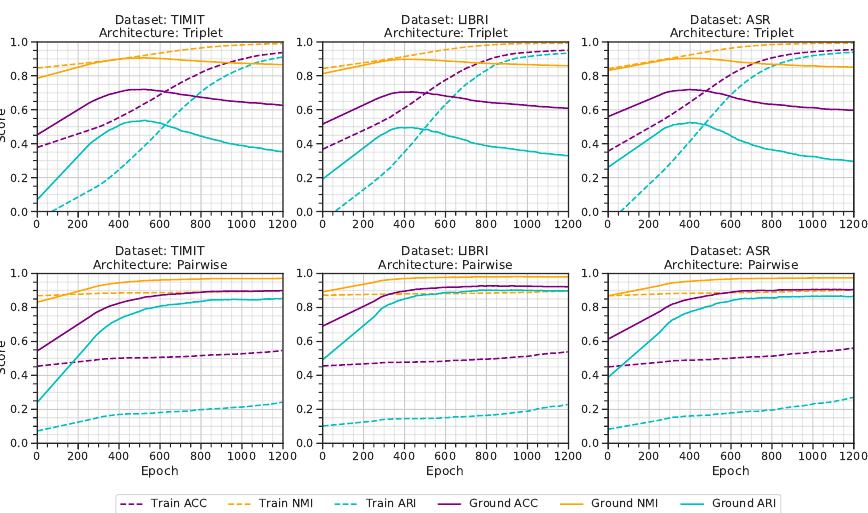
Figure 4. The graphs illustrated in the first row visualizes the metrics on training and ground dataset containing 25 speakers with impurity = 0 for triplet architecture. The lower row envisions the same for the pairwise architecture. Each column represents benchmarks carried on a single dataset.